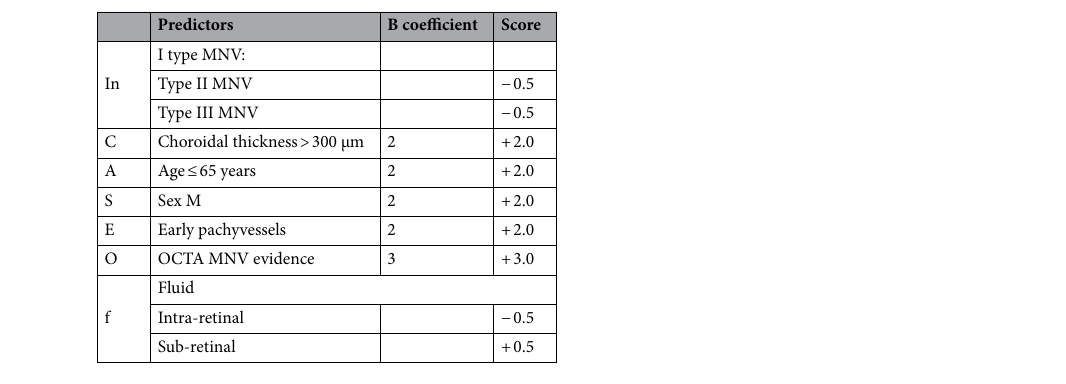
Table 4. InCASEOf scoring system.